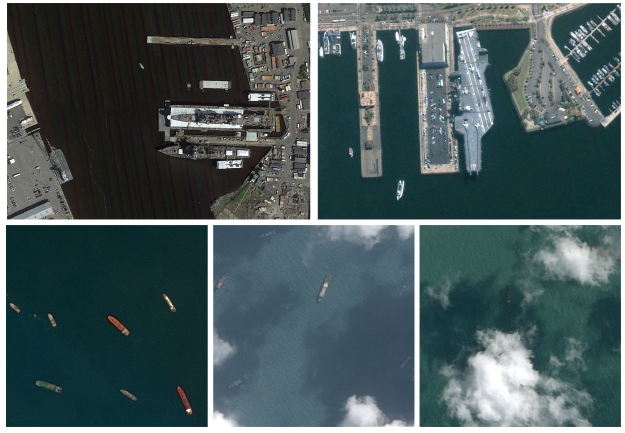
Figure 8. Typical images in HRSC2016 dataset (the first row) and Airbus dataset (the second row). Synthetic remote sensing ship datasets. To verify the superiority of the proposed method in more demanding domain adaption scenarios, we also adopt the synthetic re- mote sensing image data from the maritime ship detection competition